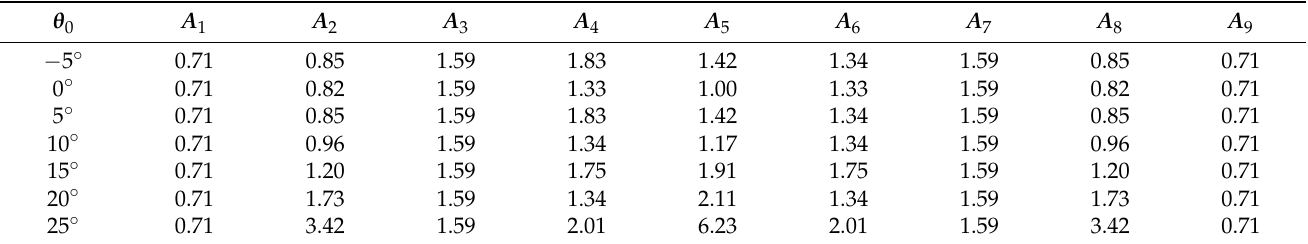
Table 1. Amplification values (at the outputs of the feeding system) that are required to obtain a raised cosine.